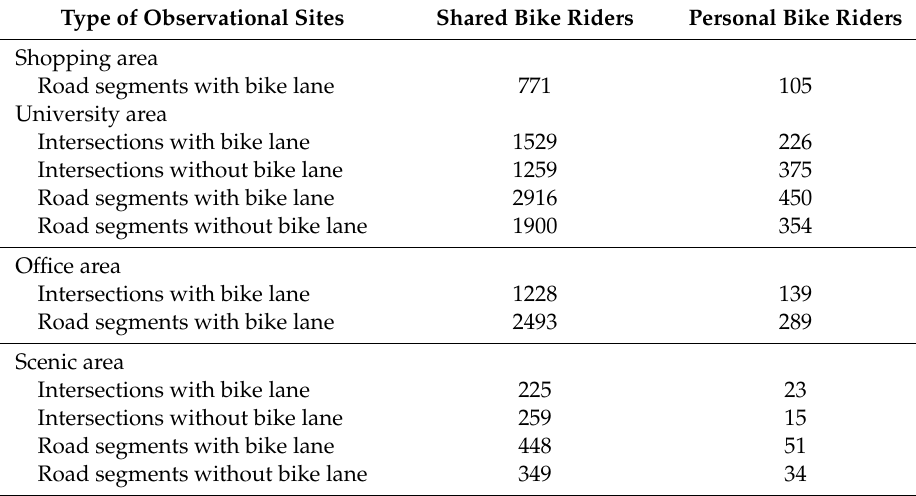
Table 1. Characteristics of 15,468 observed cyclists in Changsha, China.